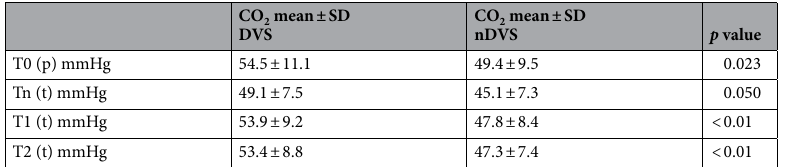
Table 2. Subgroup tCO 2 levels at different points of time. T0 baseline: no NIV Tn: with NIV (≥ 4 h use) T1: 10 min after NIV T2: 60 min after NIV. p: partial pressure, pCO 2 ; t: transcutaneous, tCO 2 .